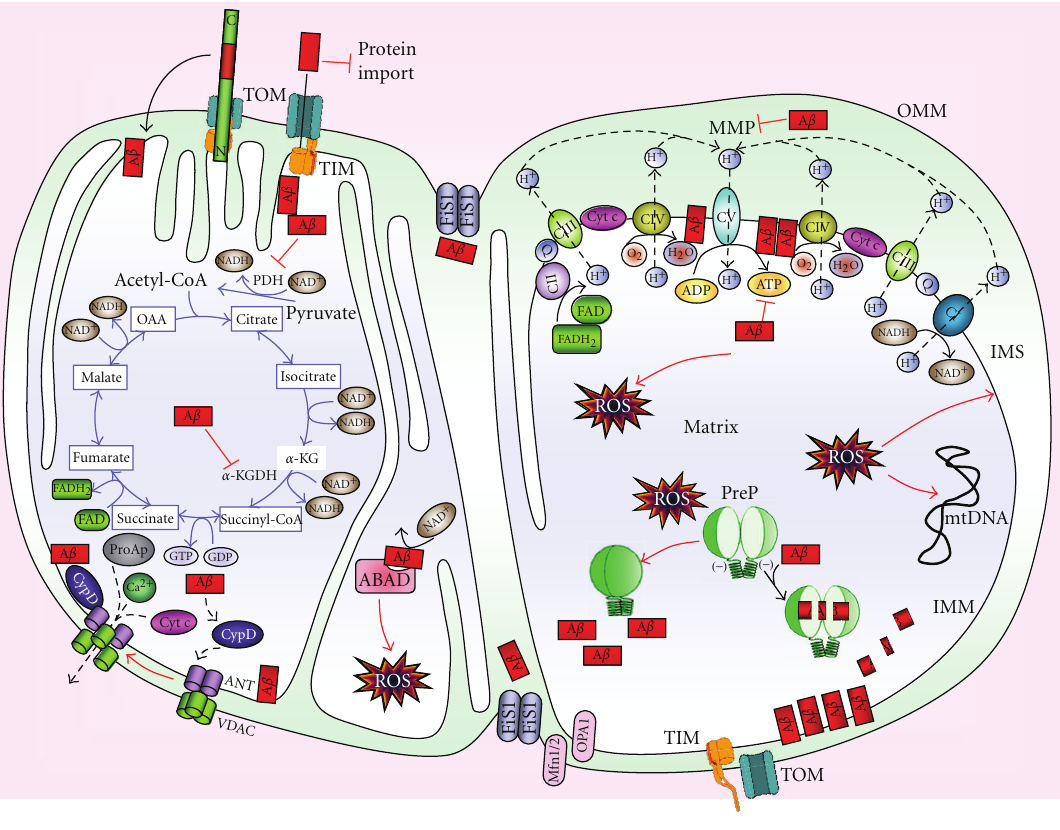
Figure 2: Mitochondrial targets of A β . A β associated with mitochondria may be deposited at several locations. Although not present exclusively on the outer mitochondrial membrane, A β that might be present at that site might influence the interaction of multiple cytosolic proteins (including those of the bcl2 family) with mitochondria, as well as a ff ect the receptor binding of cargo targeted for import into the organelle via the TOM import machinery impeding mitochondrial entry to neosynthesised nuclear-encoded proteins such as subunits of the electron transport chain (ETC) complex IV (CIV). In the intramembrane space, A β might a ff ect the functions of both the inner and outer mitochondrial membrane by multiple mechanisms including modulating their permeability. In the mitochondrial matrix, A β might interact with important components of metabolic or antioxidant mechanisms. The interaction of A β with the inner mitochondrial membrane would bring it into contact with respiratory chain complexes with the potential for myriad e ff ects on cellular metabolism. Thus, A β a ff ects the activity of several enzymes, such as pyruvate dehydrogenase (PDH) and α -ketoglutarate dehydrogenase ( α -KGDH), decreasing NADH reduction, and the ETC enzyme CIV, reducing the amount of hydrogen that is translocated from the matrix to the intermembrane space, thus impairing the mitochondrial membrane potential (MMP). The dysfunction of the ETC leads to a decreased CV activity and so to a lower ATP synthesis, in addition to increasing reactive oxygen species (ROS) production. ROS negatively influences presequence P (PreP) activity, blocking A β degradation, exacerbating mitochondrial A β presence. Moreover, ROS induce peroxidation of several mitochondrial macromolecules, such as mitochondrial DNA (mtDNA) and mitochondrial lipids, additionally impairing mitochondrial function. A β binds NAD + pocket in ABAD, blocking its activity and inducing further ROS production. A β also influences mitochondrial dynamic, by improving Fis1 presence and activity, thus increasing mitochondrial fragmentation (fission protein: Fis1; fusion proteins: Mfn1/2 and OPA1). Furthermore, A β binding to cyclophilin D (CypD) enhances the protein translocation to the inner membrane, favouring the opening of the mitochondrial permeability transition pore, formed by ANT and VDAC. Calcium storage in mitochondria is impaired, altering neuronal function; calcium is exported to the cytosol, as well as other apoptotic factors (ProAp) such as cytochrome c, apoptosis-inducing factor, Smac/DIABLO, endonuclease G, and procaspases, activating cellular apoptosis. IMM: inner mitochondrial membrane, IMS: intermembrane space, OMM: outer mitochondrial